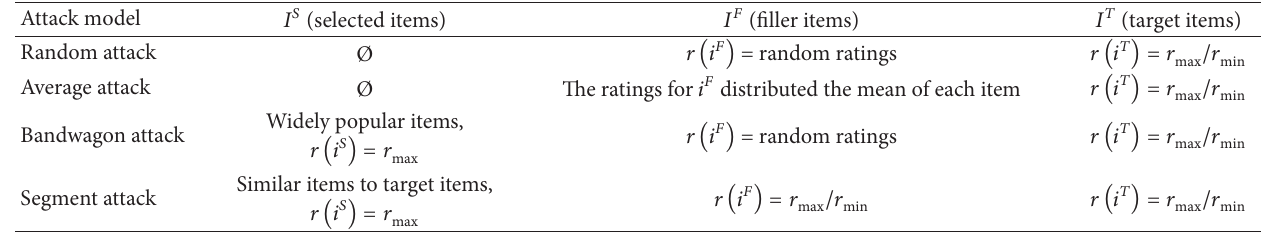
Table 1: The features of the attack